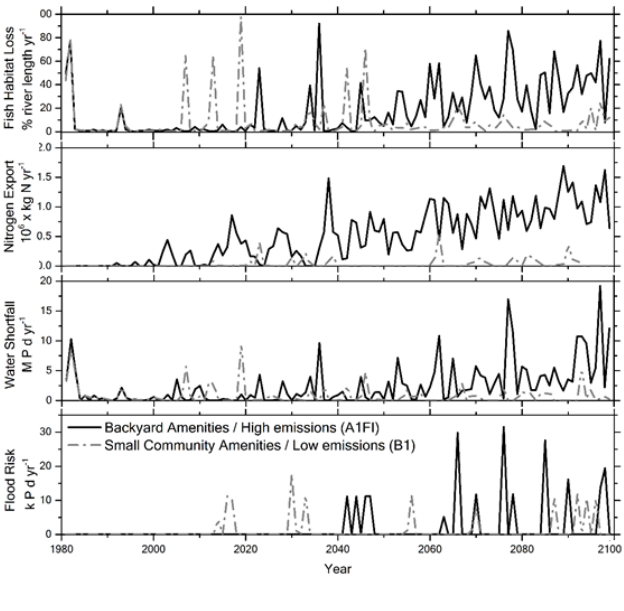
Fig. 6. Time-series of water environmental indicators for Backyard Amenities / High Emissions and Small Community Amenities / Low Emission scenarios through 2100 for (a) Fish Habitat Loss (% river length impairment per year), (b) Nitrogen Export (10 6 x kg N per year), (c) Water Shortfalls (Million (M) person days per year), and (d) Flood Risk (Thousand (k) person days per